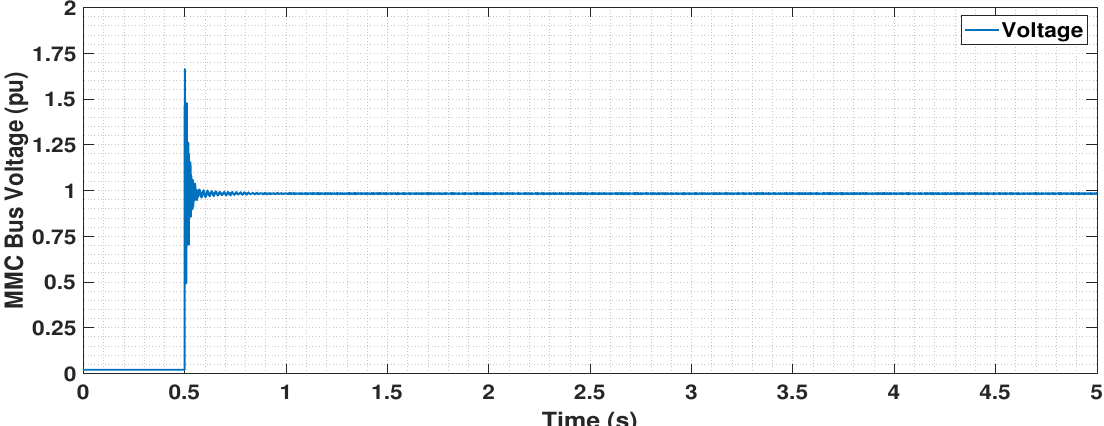
Figure 13. Voltage in p.u. at MMC bus upon CB-5a closing